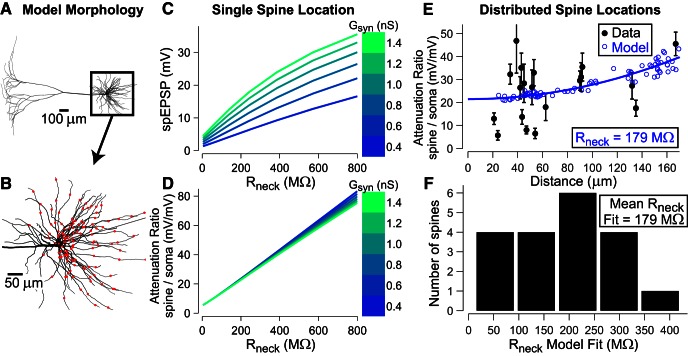
Estimating Rneck using biophysical models. A, A morphologically realistic multicompartmental model of a L5 pyramidal neuron was used (Mainen and Sejnowski, 1996). The passive electrical properties of the model were as follows: Rm = 30,000 Ω cm2, Cm = 0.75 μF cm−2, and Ra = 150 Ω cm. The resulting somatic input resistance was 43 MΩ. B, Basal dendrite region, which was sampled by moving a spine head and neck with passive properties sequentially between 117 different locations to test the role of the spine neck resistance Rneck. C, With the test spine at a single dendritic location, Rneck increases the spEPSP and values depend on the maximal synaptic conductance Gsyn (right side color bar for families of curves). D, At the same time, attenuation ratio of spine–somatic EPSP amplitude appears very linear and insensitive to Gsyn. E, For each Rneck value, EPSPs were generated at all 117 basal dendritic locations, and the spine–soma attenuation ratio was plotted versus the distance of each model site (open circles) along with a quadratic fit (blue line) and superimposed with the experimental attenuation values (N = 19, closed circles with error bars). F, For each experimental attenuation data point (distance, spine–soma attenuation), the model’s Rneck value that led to the quadratic fit (blue line) coinciding with that point was determined and plotted in a histogram (mean 179 ± 25 SE MΩ).